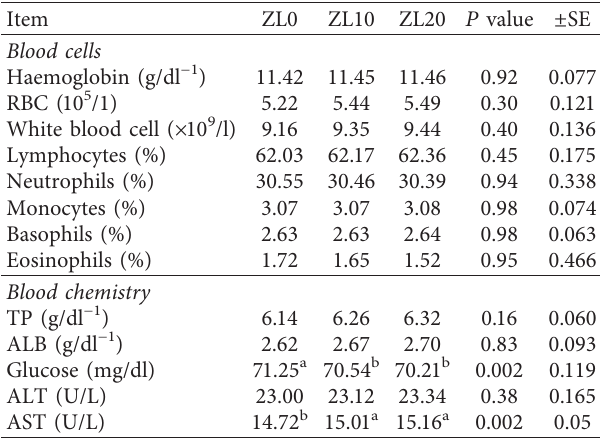
Table 4: Haematological and serum biochemical indices of rabbits fed on a diet containing ZL.